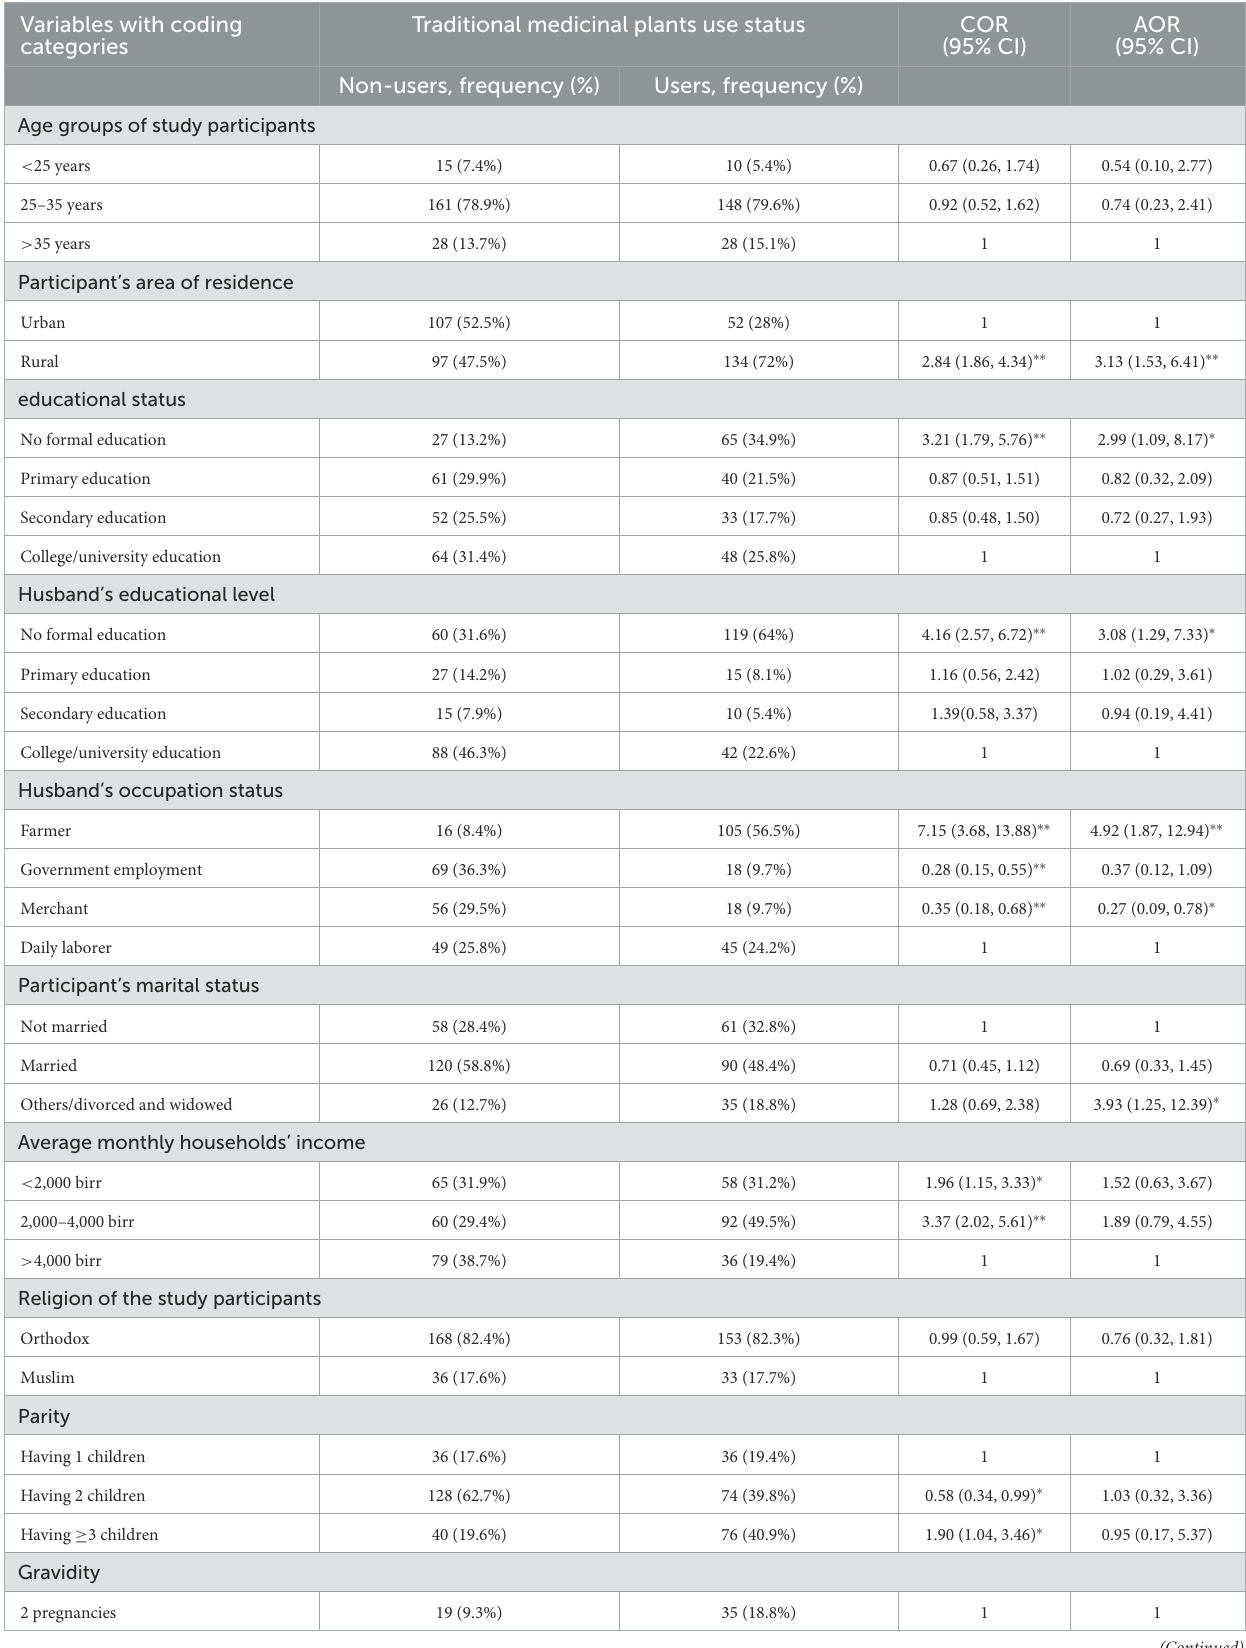
TABLE 5 Univariable and multivariable analysis results of factors associated with medicinal plant use in East Gojjam Zone, Northwest Ethiopia, 2021 ( N = 390). Variables with coding